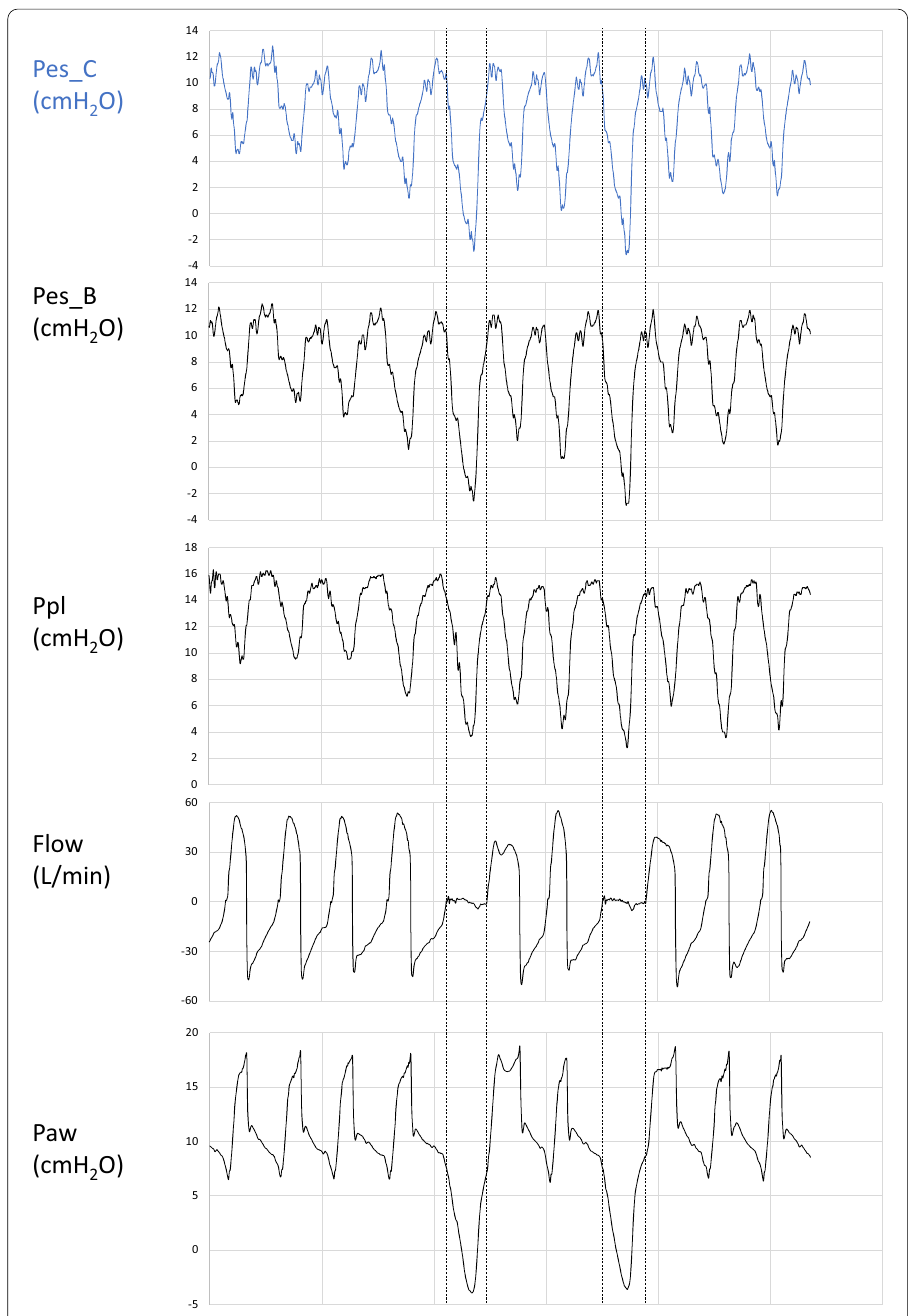
Fig. 4 Representative simultaneous esophageal and pleural pressures waveforms. Simultaneous esophageal and pleural pressure traces are recorded from air-filled esophageal catheter (Pes_C), esophageal balloon catheter (Pes_B) and pleural catheter (Ppl), together with airway pressure (Paw) and Flow traces in a patient in assisted mode. Two successive end-expiratory occlusion tests induce increased esophageal, pleural and airway pressure deflections and are delimited by vertical